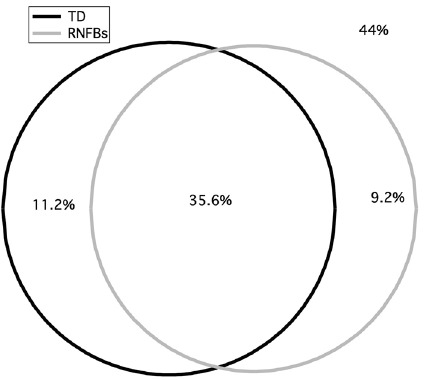
Figure 2. Venn diagram comparing perimetric defect (as derived from the total deviation maps) and the structural defect as observed from the reflectance of the retinal nerve fiber layer bundles (RNFBs) using the optical coherence tomographer (OCT). Each circle represents the proportional area (defective locations) to the number of the locations. The overlapping proportion between the structural and functional defects was 35.6%.